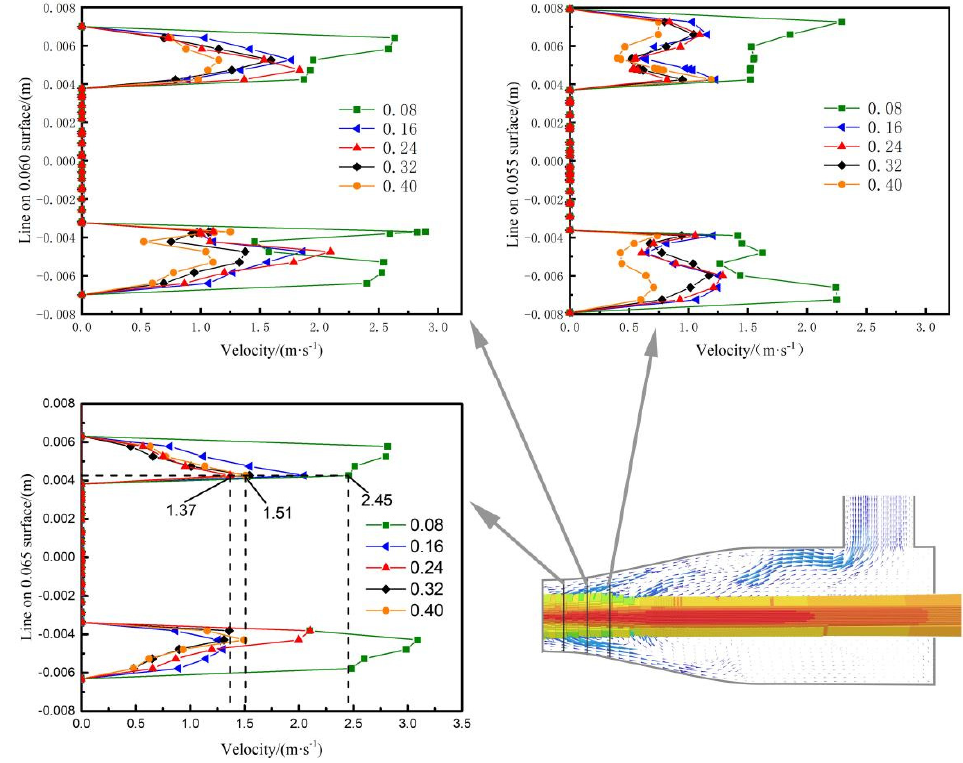
Figure 6. Velocity change curve of gas–water mixing zone with different gas–liquid ratios.